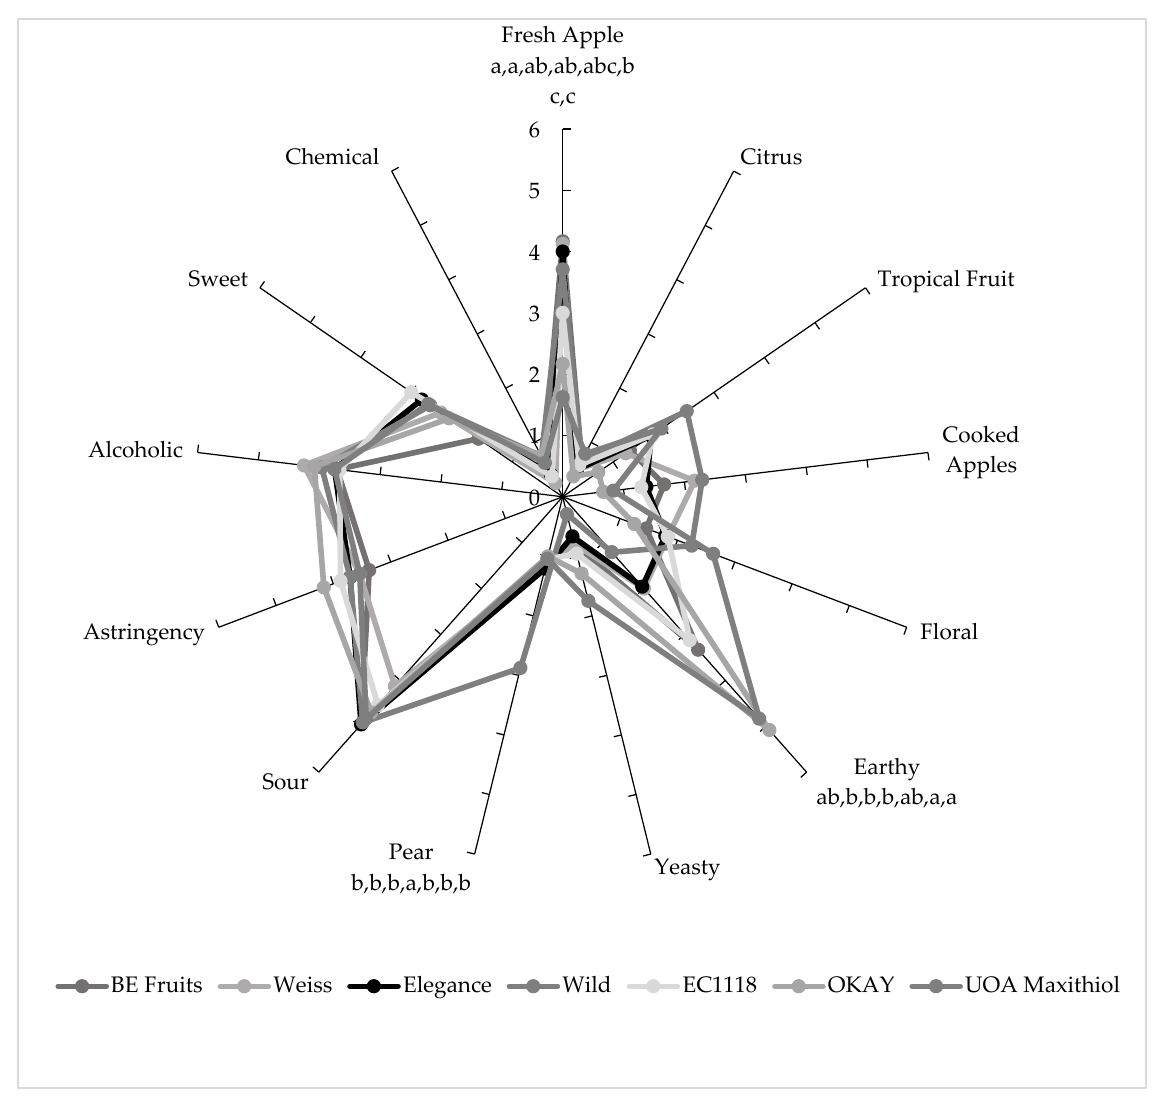
Figure 4. Sensory profiles of ‘Pink Lady’ ciders made using 7 different yeast strains shown for ‘BE Fruits’, ‘Weiss’, ‘Elegance’, Wild, ‘EC1118’, ‘OKAY’. And ‘UOA Maxithiol’ yeasts, respectively). Lletters under the attributes ‘fresh apple’, ‘pear’, and ‘earthy’ indicate a statistically significant difference at p < 0.001.